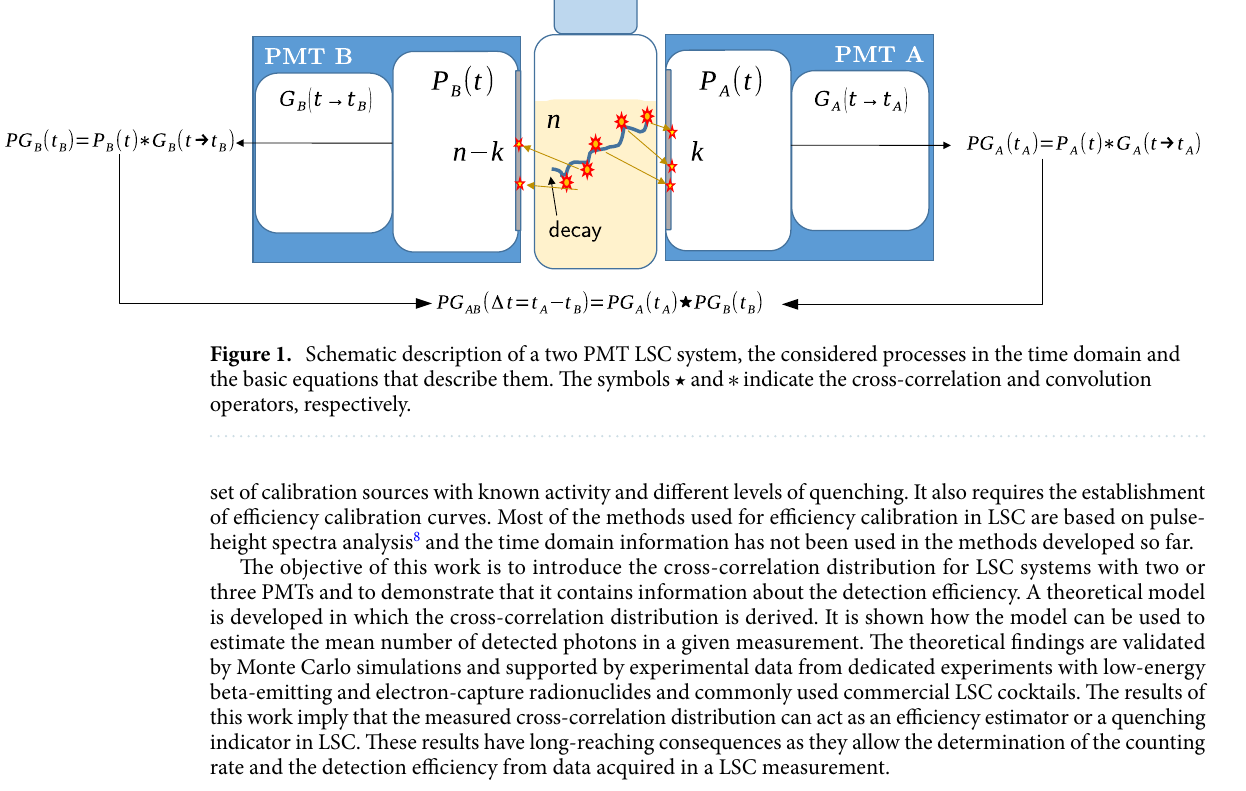
indicate the cross-correlation and convolution ∗